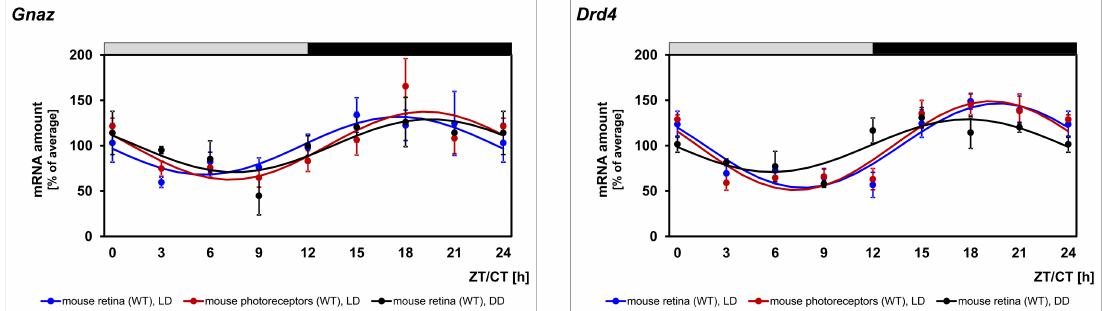
Fig 4. Daily profiling of Gnaz mRNA in photoreceptors and constant darkness. Transcript levels of Gnaz and Drd4 were monitored under LD in mouse retina (blue lines) and mouse photoreceptors (red lines), as well as in mouse retina under DD (black lines) using qPCR. The mRNA levels are plotted as a function of ZT and circadiantime (CT). The lines represent the periodicsinusoidal functions determined by cosinoranalysis. Data represent a percentage of the averagevalue of the transcript amount duringthe 24-h period. Statistical analysisof transcriptional profilingis providedin Table 2 . Note that Gnaz mRNA rhythmicity is also evident in photoreceptors and persists in constant darkness.The value of ZT0 is plotted twice at both ZT0 and ZT24. The solid bars indicate the dark period. Each value represents mean ± SEM (n = 4; each n represents one animal(two retinae) for wholeretina preparations and two animals(four retinae) for photoreceptor preparations).